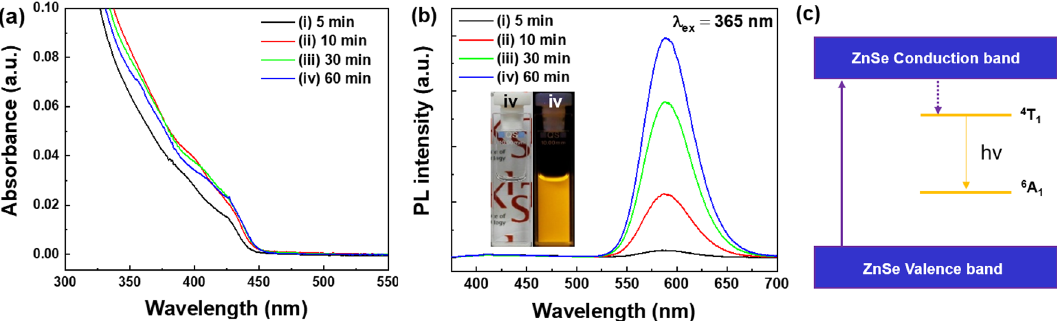
Figure 1. ( a ) Absorption and ( b ) PL spectra of the as-synthesized ZnSe:Mn 2+ (5%) d-C QDs as a function of reaction time (i: 5 min, ii: 10 min, iii: 30 min and iv: 60 min). The inset in ( b ) shows photographs of the ZnSe:Mn 2+ (5%) d-C QDs solution under indoor light (left) and UV light (right) (λ ex = 365 nm). ( c ) Schematic energy level diagram showing the emission from the ZnSe:Mn 2+ d-C